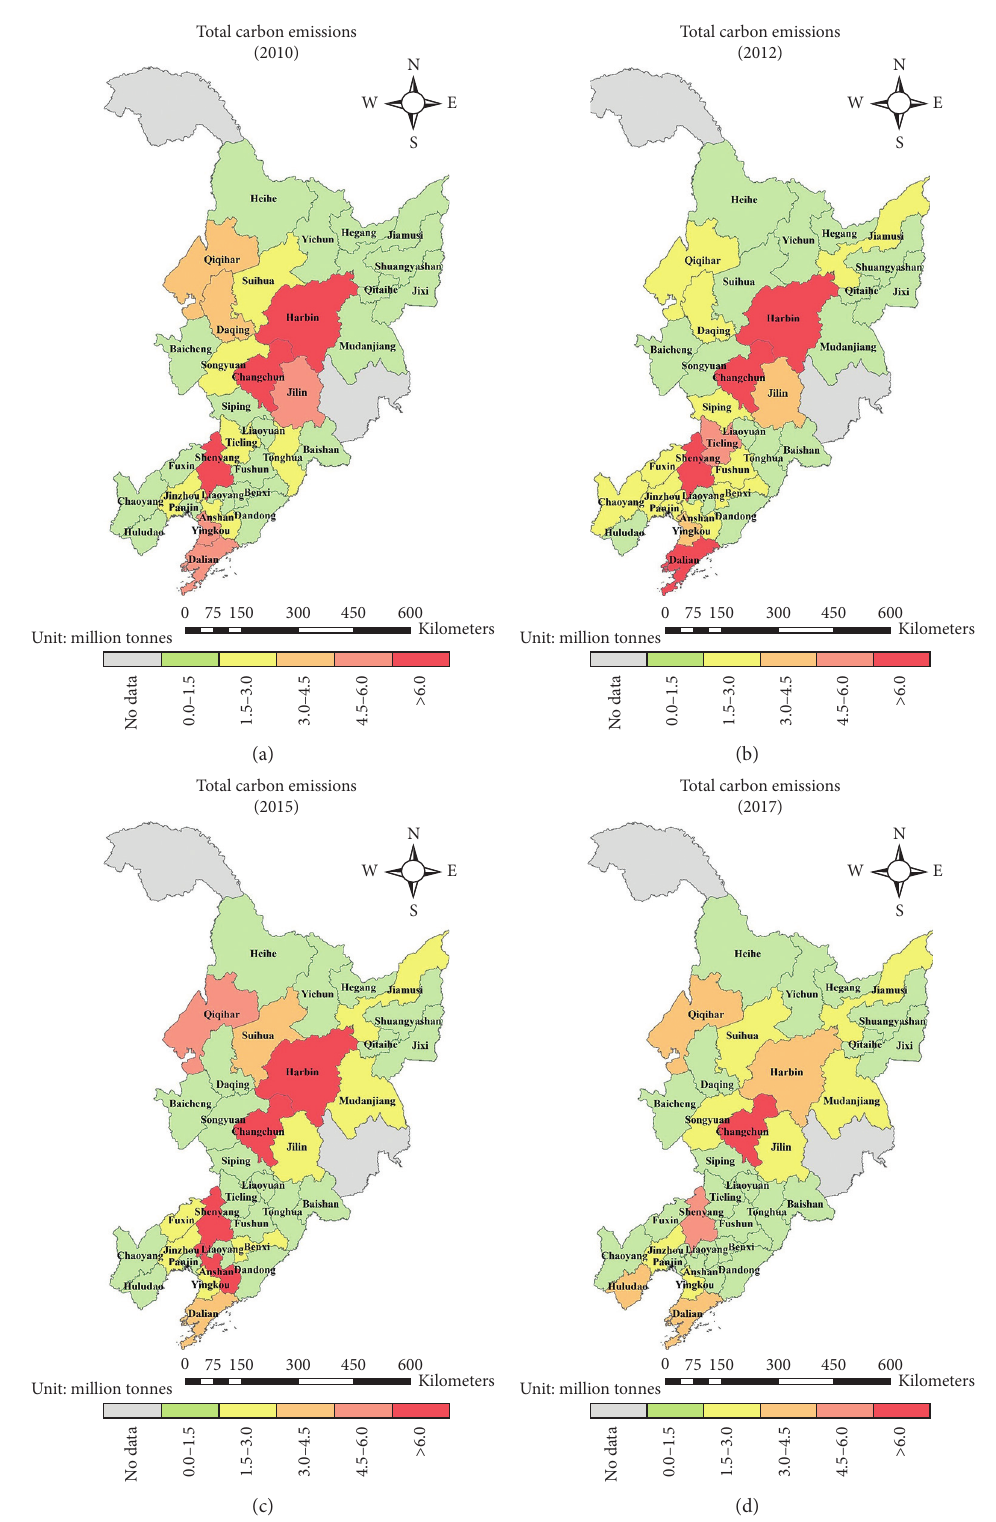
Figure 8: Spatial patterns of the total CO 2 emissions associated with infrastructure construction of 34 cities in Northeast China in 2010, 2012, 2015, and